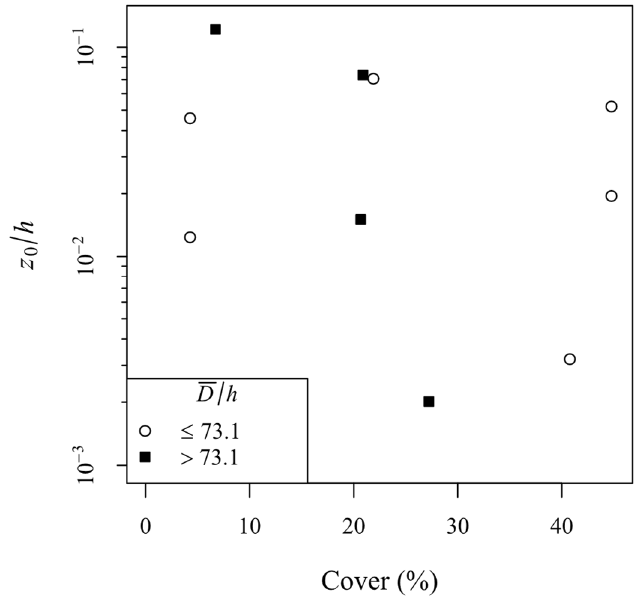
Figure 7. Relationship between z 0 / h and cover. The points were divided into high and low categories based on the average of D / h